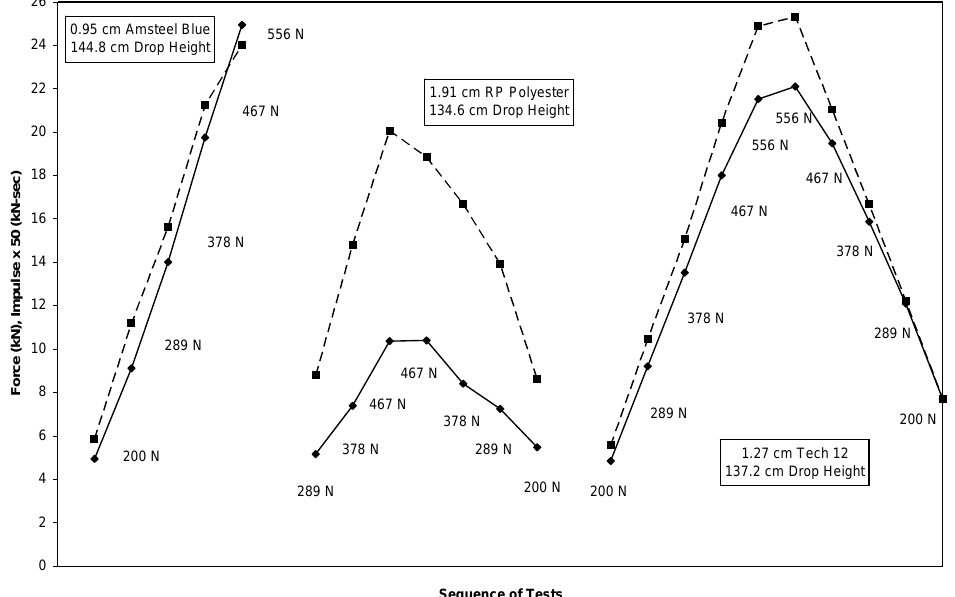
Fig. 11. Three sequences of dynamic tests on new ropes with constant height and varying weight; solid = maximum force; dashed = impulse. weights of 289 N, 378 N, and 467 N. Then another test was conducted with 467 N, followed by tests with decreasing weights of 378 N, 289 N, and 200 N. The third sequence involves five tests with increasing weights, and five tests with decreasing weights, for a 1.27-cm-diameter Tech 12 rope which has a tight-braid construction. The curves